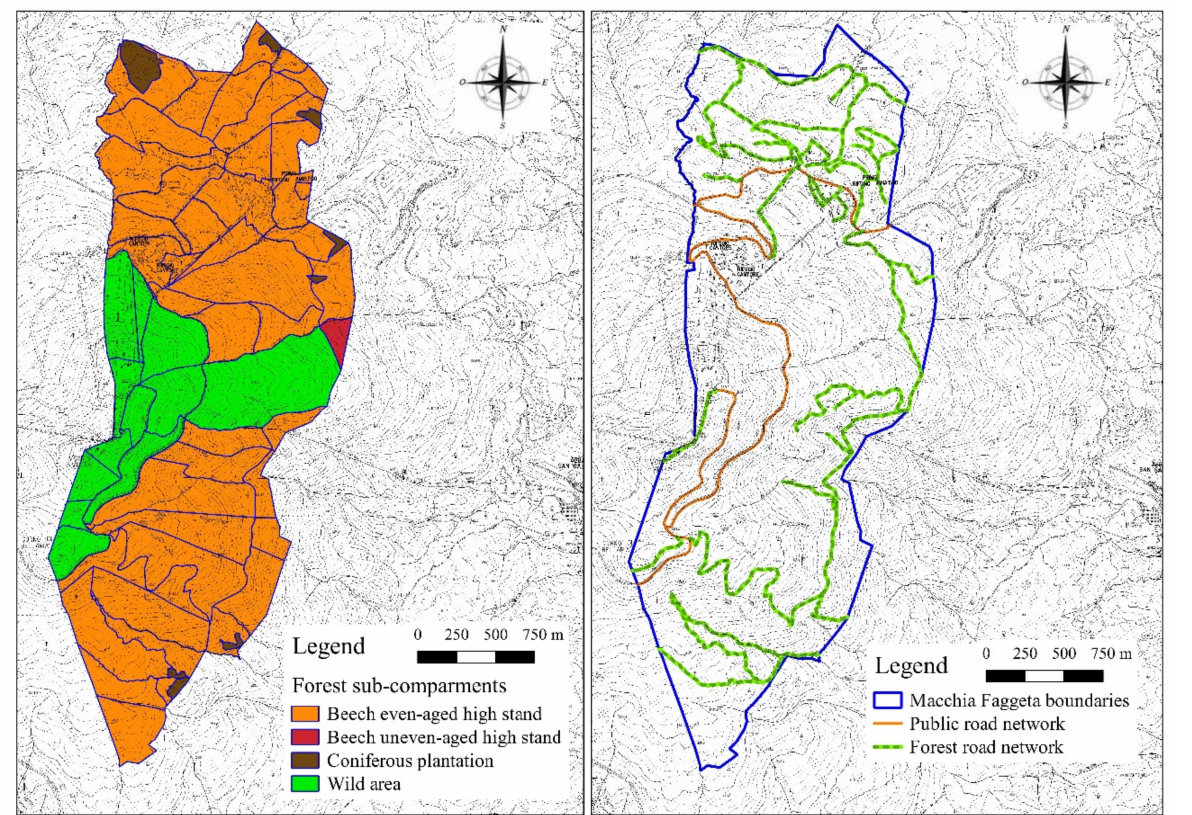
Figure 1. On the left, the subdivision into forest typologies of the study area. On the right, Macchia Faggeta boundaries and road network on a technical map of the Tuscany